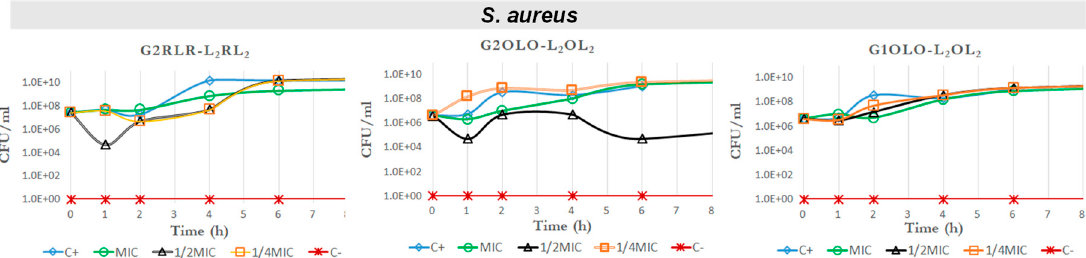
Figure 4. Time–kill curves against S. aureus for G2RLR-L 2 RL 2 , G2OLO-L 2 OL 2 and G1OLO-L 2 OL 2 .